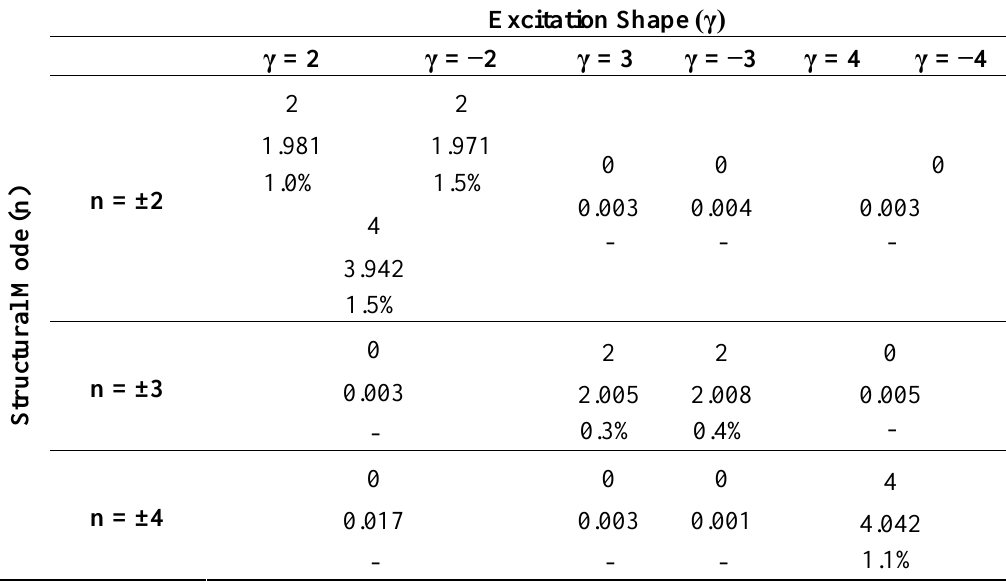
Table 3. Amplification of the resonances (A ( = 8 Hz) due to the different excitation patterns. Analytical, experimental and disk